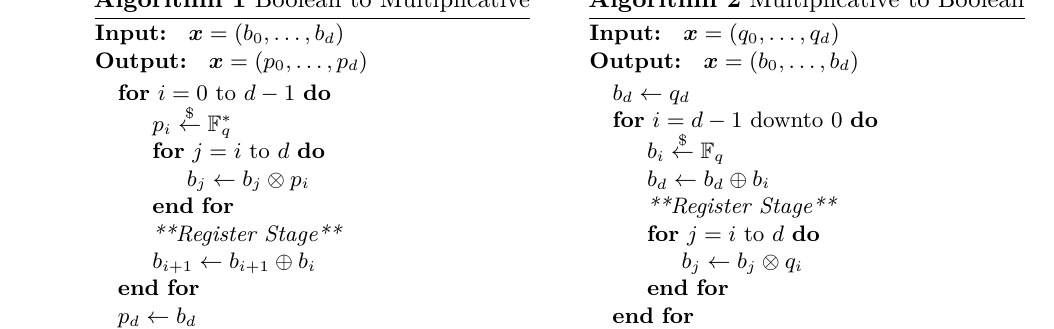
Algorithm 1 Boolean to Multiplicative Algorithm 2 Multiplicative to